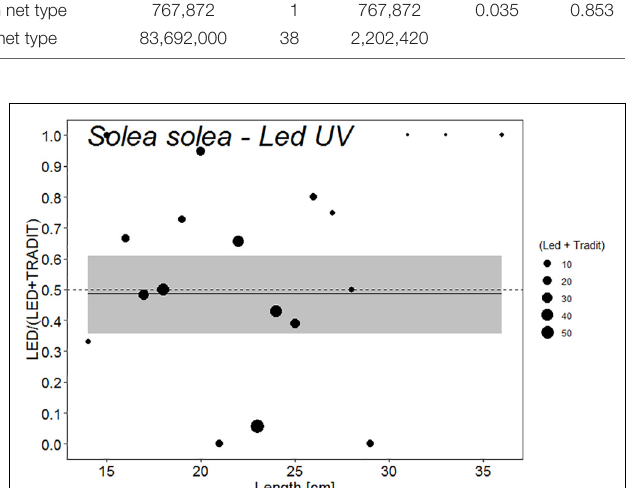
FIGURE 5 | GLMM modeled proportions of the total catches caught by the net equipped with LED. Interpretation: a value of 0.5 indicates an even split between LED and CTRL net. Shaded area is the 95% confident interval. The size of dots refer to the sum (LED + CTRL) of specimens for each length